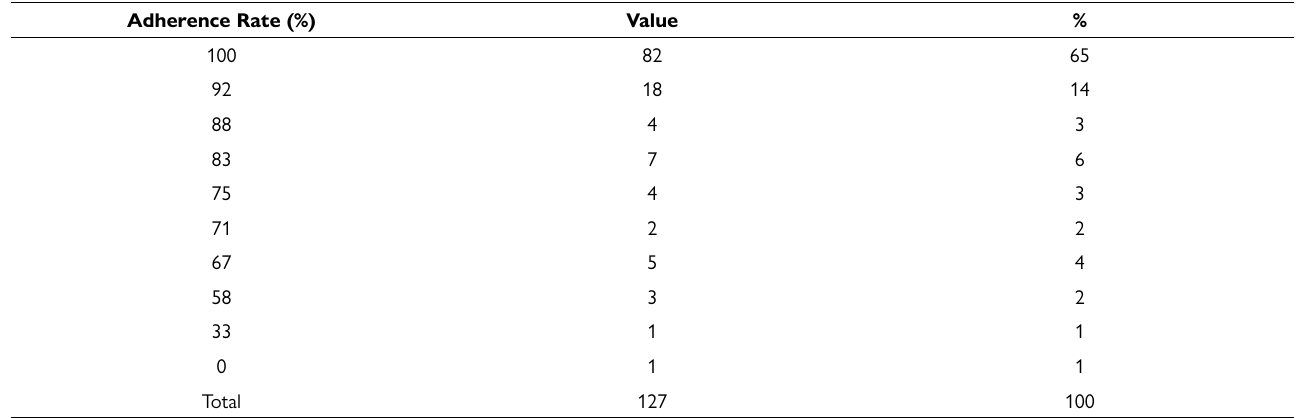
Table 3. Frequency of the treatment adherence